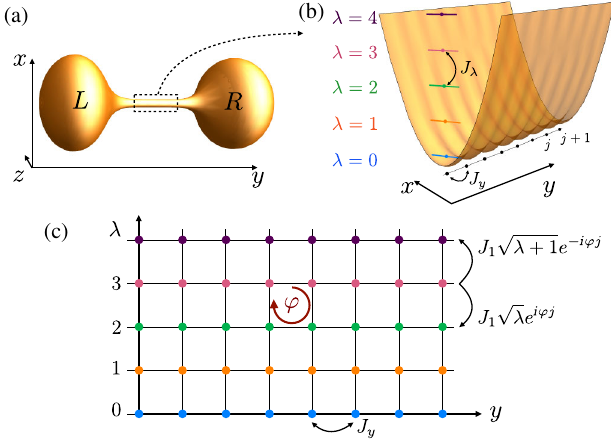
FIG. 1. (a) A sketch of the two-reservoir geometry [29], which is used as a basis for our shaken-channel model. A constriction potential is imprinted on a 3D Fermi gas so as to create a quantum wire, on top of which, a one-dimensional optical lattice is produced. The nonconstricted parts of the system form the two atomic reservoirs at the left ( L ) and right ( R ) sides of the channel. (b) A close-up view of the channel region shows the harmonic confinement associated with the constriction potential, as well as the optical lattice aligned along the channel; the corresponding sites are indexed by j and the hopping amplitude denoted J y . The harmonic oscillator levels λ are reinterpreted as lattice sites along a synthetic dimension. The potential is then periodically shaken, as proposed in Ref. [56], to generate hopping processes along the synthetic dimension λ ; the corresponding ffiffiffi p λ hopping amplitude is denoted J λ ¼ J 1 . (c) For a suitable shaking protocol, the system is described by a 2D tight-binding model in the y - λ plane, which includes the effects of a tunable artificial magnetic field; the corresponding flux per plaquette is denoted by φ